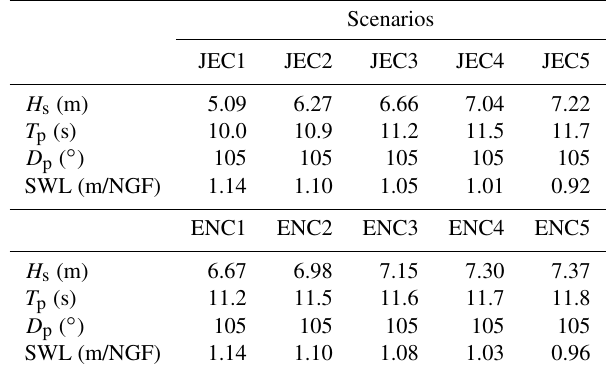
Table 5. Extreme scenarios from 100-year joint exceedance con- tour (JEC1 to JEC5) and 100-year environmental contour (ENC1 to